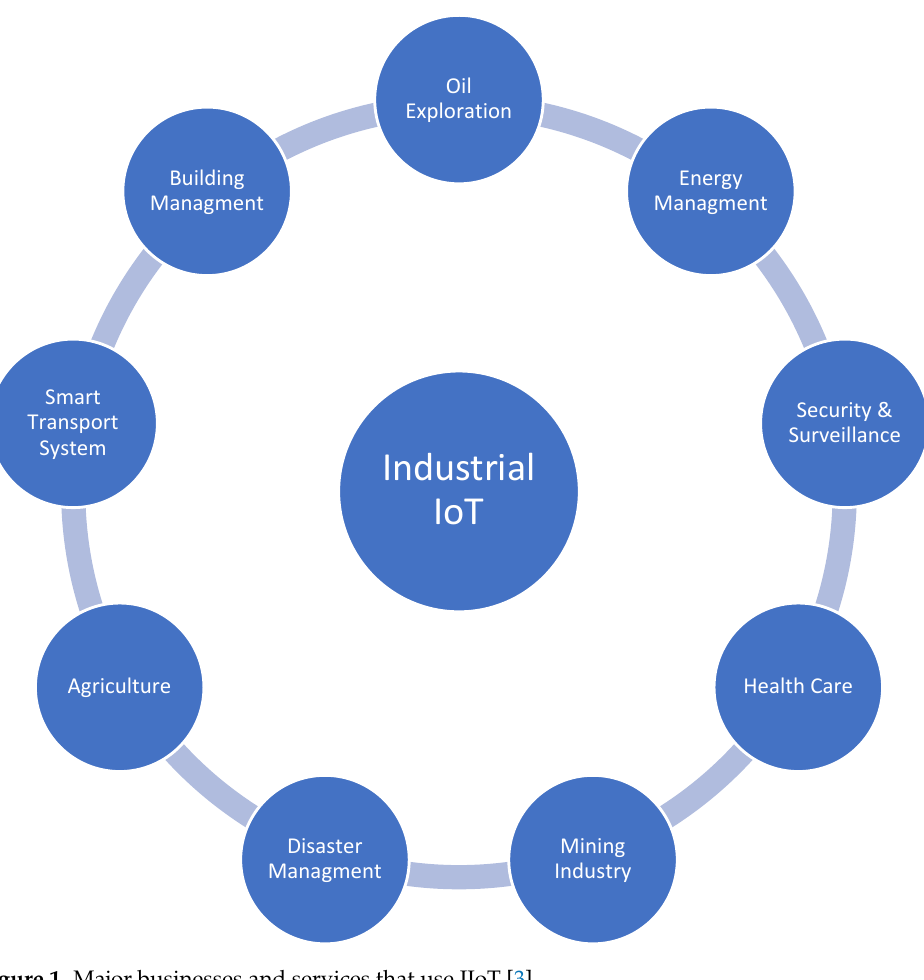
Figure 1. Major businesses and services that use IIoT [3].